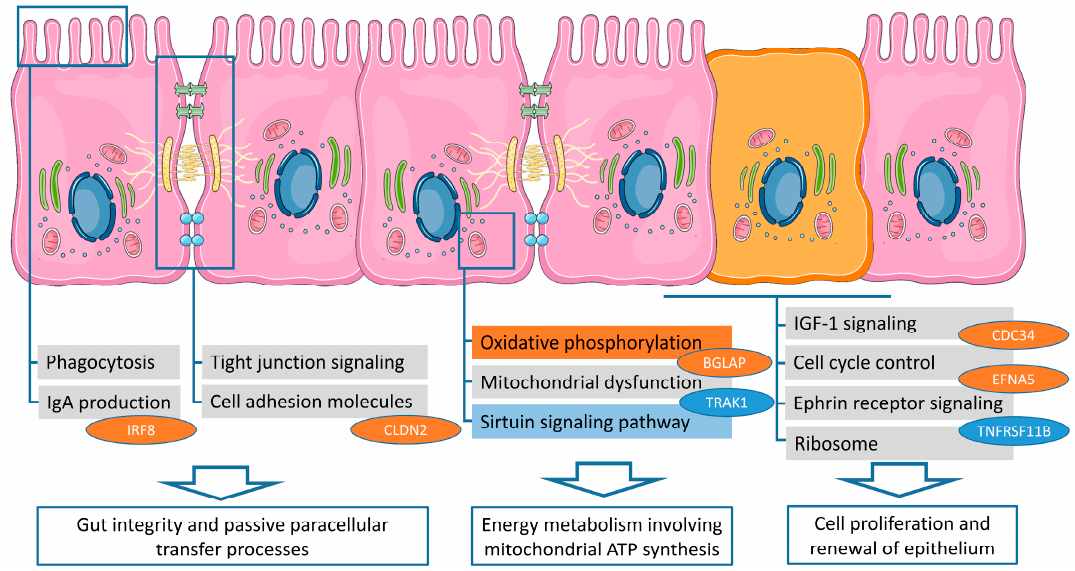
Figure 4. Conceptual model of the ileal epithelium of Japanese quail with divergent PU status. The model links gut integrity, energy metabolism, and enterocyte proliferation rate as potential molecular determinants for e ffi cient PU. Pathways and vitamin D responsive hub genes indicate transcriptional up- (orange items) or down-regulation (blue items) in the high PU group compared to the low PU group. Grey boxes indicate transcriptional e ff ects not predicted based on the Ingenuity Pathway Analysis (IPA) z -score.